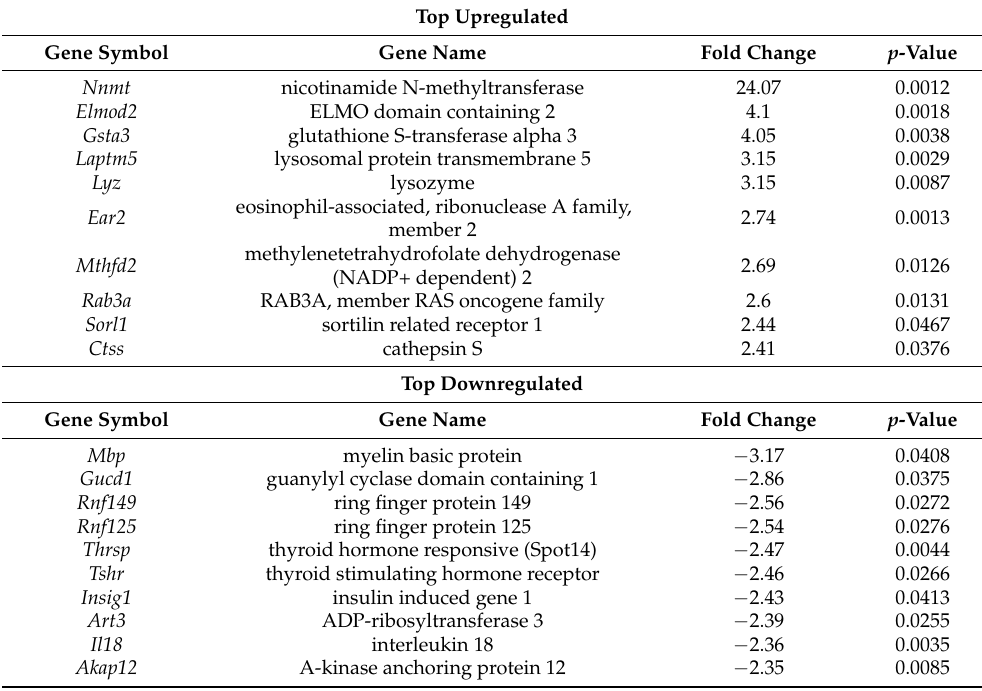
Table 3. Top differentially expressed genes in BAT of Trsp f/f -Ucp1-Cre +/ − mice acutely exposed to